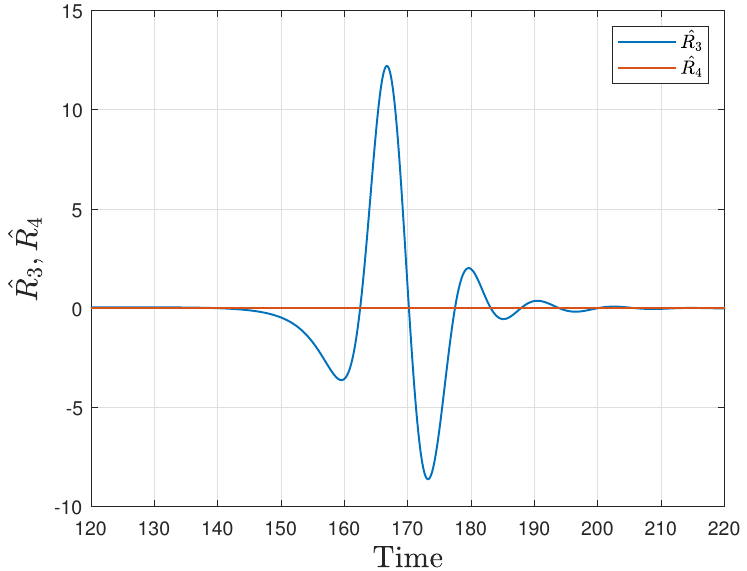
Figure 4. Waveforms for dipole perturbation, l = 1, with ˆ Q = 0.9, M = 1, and ˆ q = − 0.8. Data were collected at r obs = 100. Notice how in this case, there is no gravitational response, Ψ should be, but there is the response associated with χ